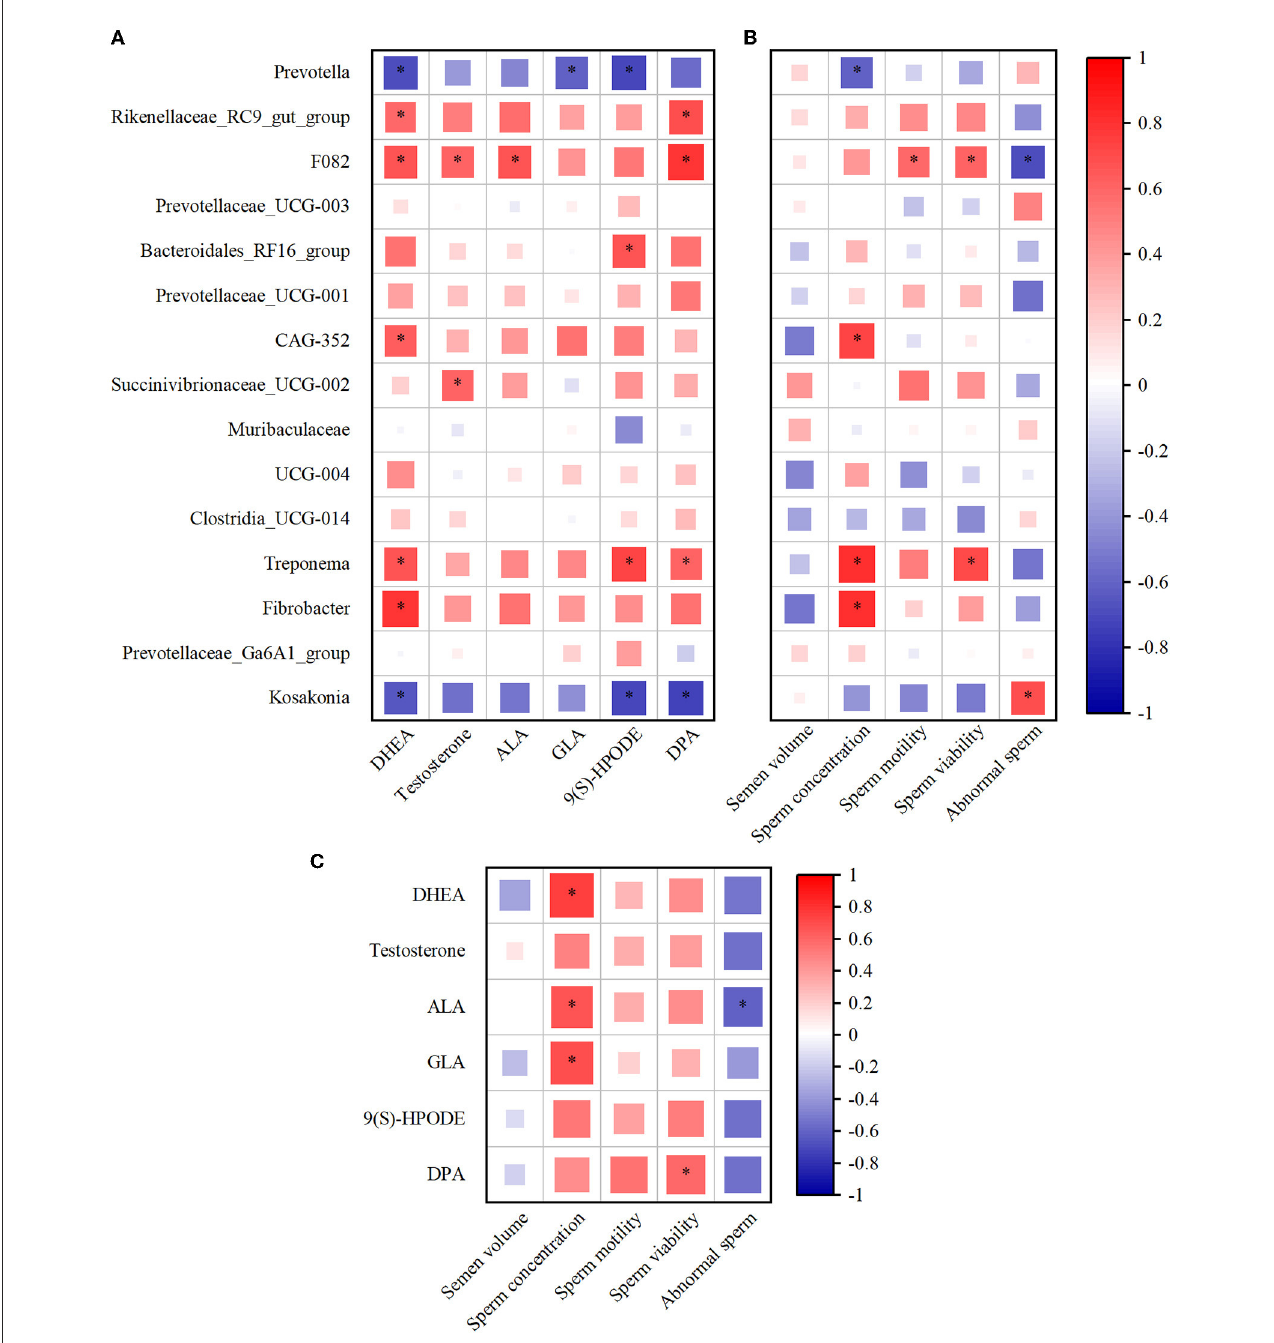
FIGURE6 The alteration of rumen microbiota and metabolites was closely associated with the semen quality. (A) Spearman’s correlation analysis of top15 genus microbiota levels with DHEA, testosterone, ALA, GLA, 9(S)-HPODE, and DPA levels. (B) Spearman’s correlation analysis of top15 genus microbiota levels with semen quality parameters (the average of semen quality of each goat obtained from the last two collections before the end of the experiment). (C) Spearman’s correlation analysis of semen quality parameters with DHEA, testosterone, ALA, GLA, 9(S)-HPODE, and DPA levels. Red indicates a positive correlation, and blue indicates a negative correlation. * P < 0.05. DHEA, dehydroepiandrosterone; ALA, Alpha-Linolenic acid; GLA, Gamma-Linolenic acid; DPA, Docosapentaenoic acid; 9(S)-HPODE, 9-S-Hydroperoxylinoleicacid.